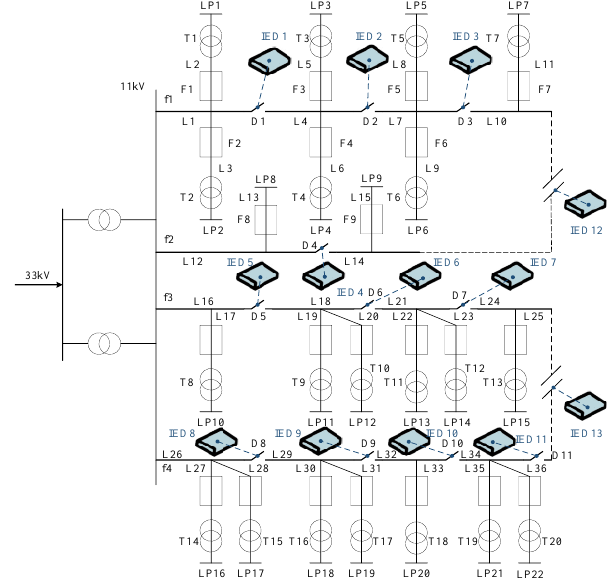
Figure 12. Structure of the distribution network CPS.